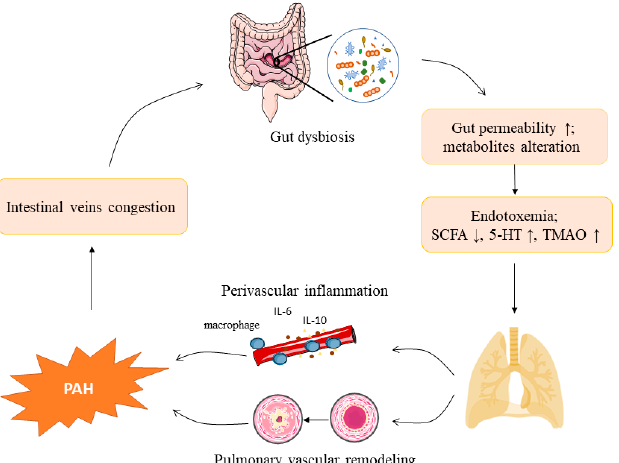
Figure 1. The roles and underlying mechanisms of gut microbiota in pulmonary arterial hyperten- sion. A shift in gut microbiota composition causes an increase in gut permeability, which leads to bacteria translocation and metabolic endotoxemia. Gut dysbiosis also changes the circulatory levels of gut metabolites such as TMAO, 5-HT, and SCFAs. Collectively, endotoxin and metabolic prod- ucts exert on pulmonary vasculature, causing pulmonary perivascular inflammation, pulmonary vascular re-modeling, and eventually PAH. Long-term PAH leads to intestinal vein congestion, which in turn contributes to gut dysbiosis. TMAO: trimethylamine N-oxide; 5-HT: 5-hydroxytryp- tophan; SCFAs: short-chain fatty acids; IL-6: interleukin-6; IL-10: interleukin-10; PAH: pulmonary arterial hypertension, ↑ increased; ↓ decreased .